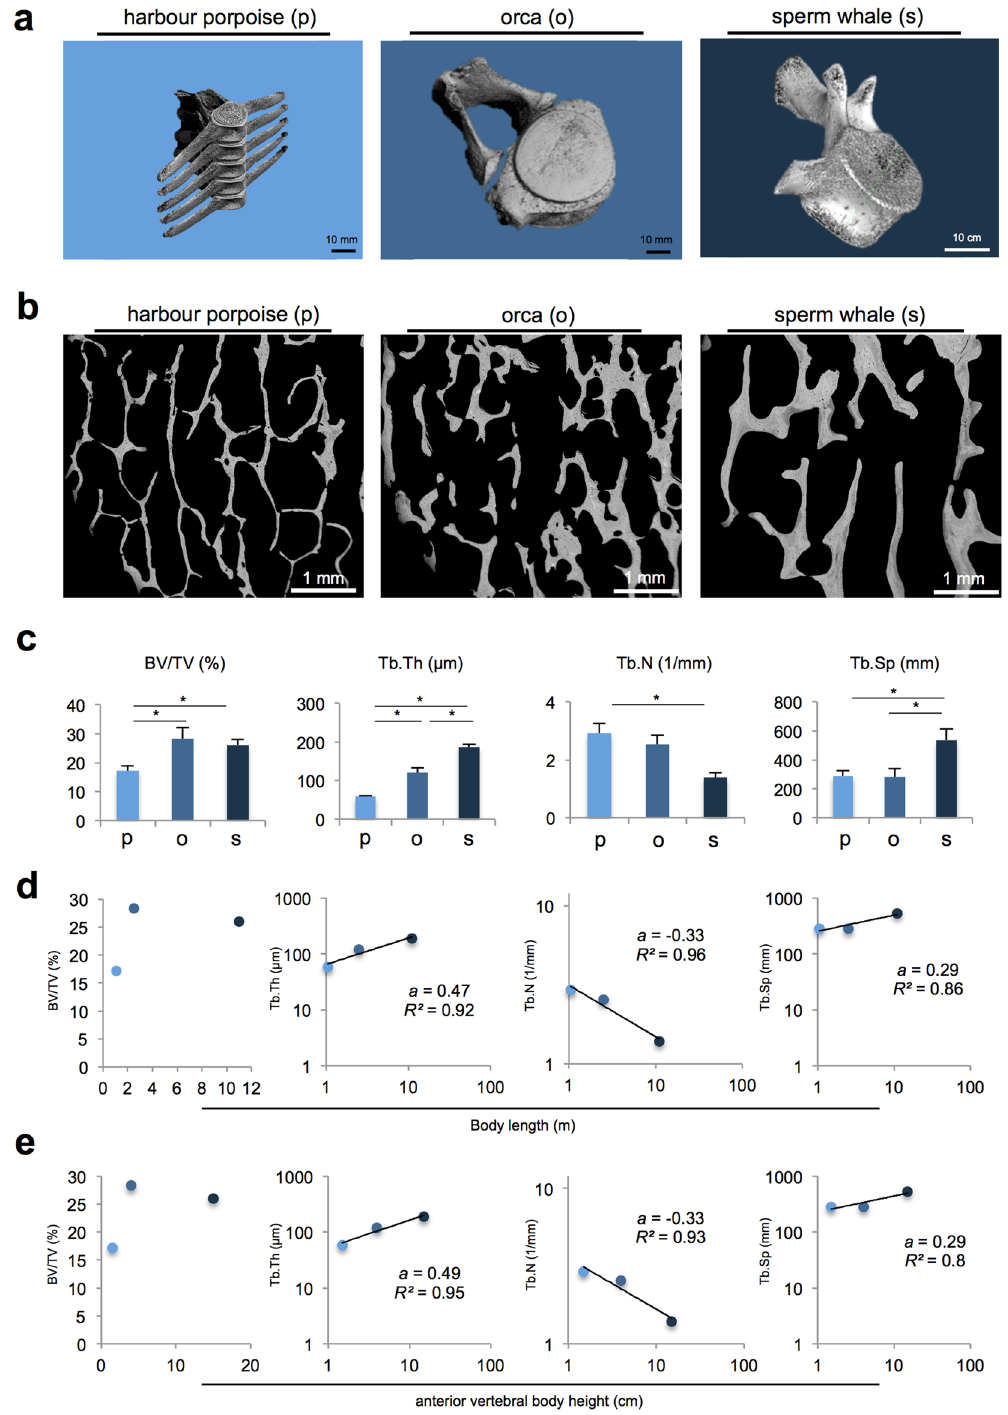
Figure 1. Bone morphometry and scaling relationship of L1. ( a ) Three-dimensional reconstruction of the lumbar vertebral body L1 of the harbour porpoise (p), orca (o) and sperm whale (s). ( b ) Overview of the bone microstructure of the three whale species. Images obtained by backscattered electron microscopy (BSEM). ( c ) Comparative histomorphometric analyses revealed significant differences between the three whale species, with the sperm whales showing the thickest, fewest and most separated trabeculae and the orca showing the highest bone volume fraction. * P < 0.05. ( d ) Trabeculae scale with body size and show a negative allometric relationship for Tb.Th, Tb.N and Tb.Sp but not BV/TV. ( e ) Anterior vertebral body height and bone structure parameters present the same negative allometric scaling